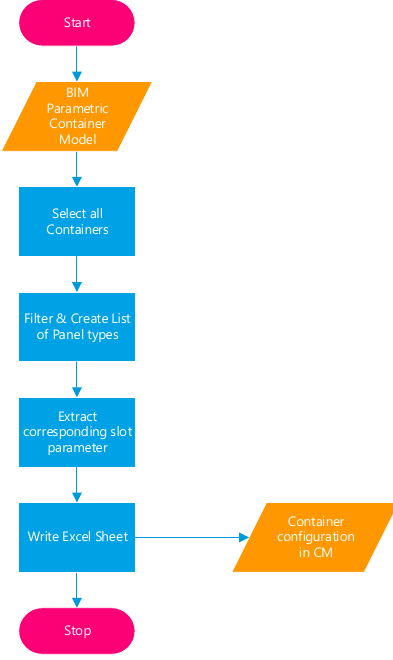
Figure 8. Parameter N_SidePanel in the BIM object library.